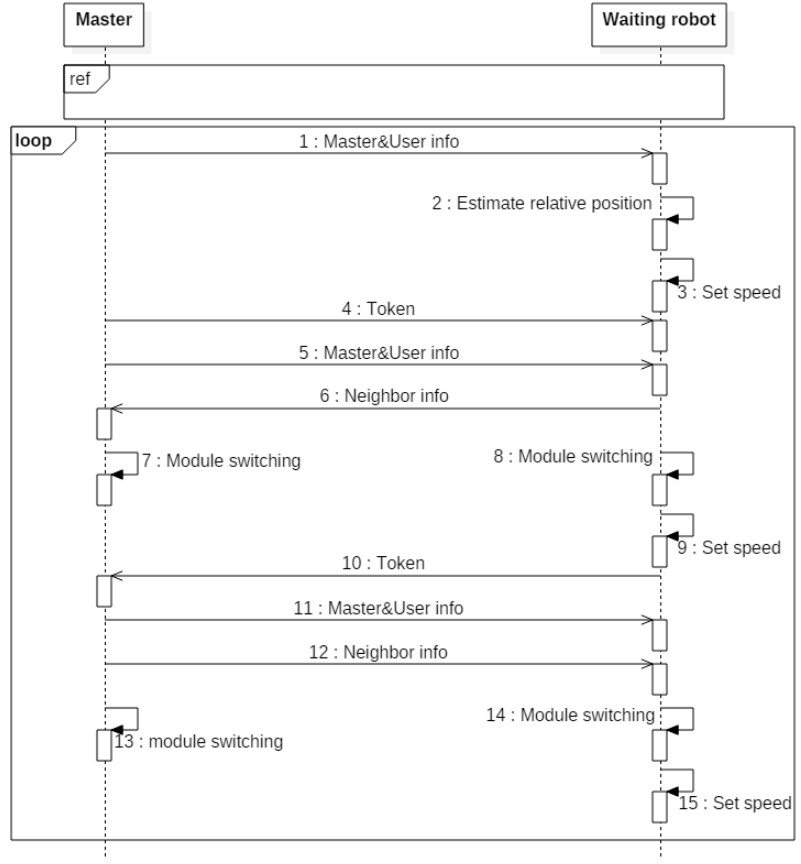
Figure 9. Simple swarm-driving process.